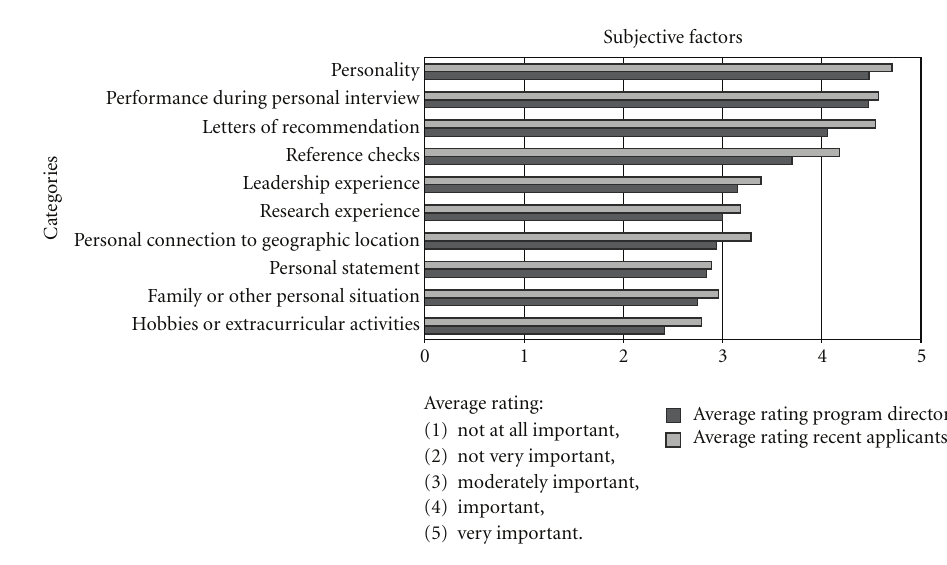
Figure 2: Bar chart comparing the importance of various objective fellowship program selection factors between program directors and recent fellows.